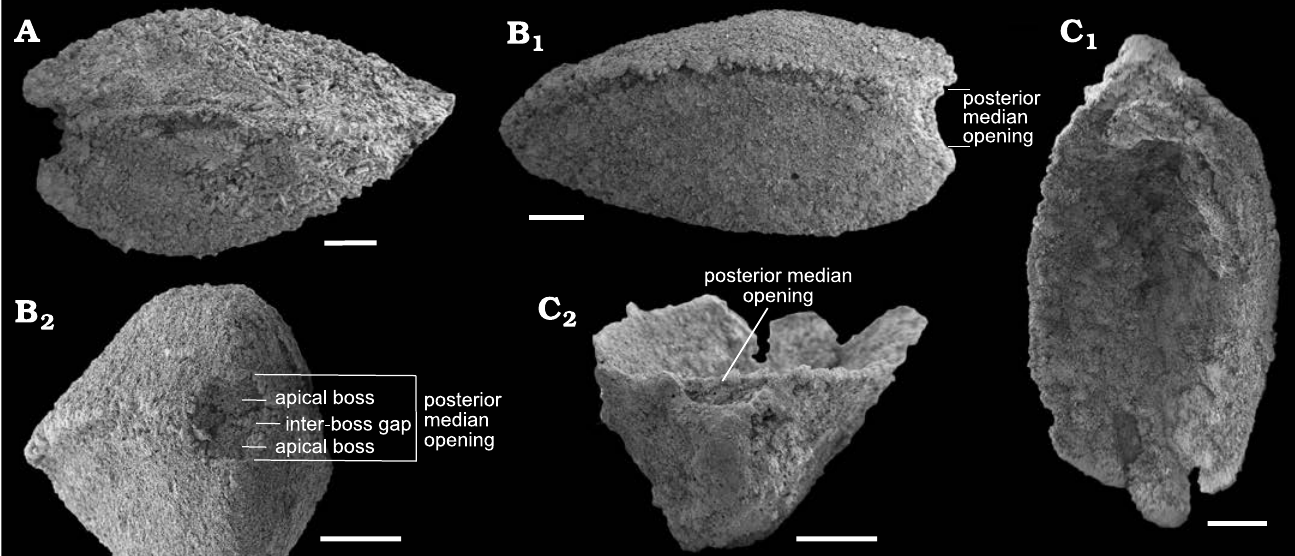
Fig. 7. SEM micrographs of stenothecoid pan-brachiopod Stenothecoides cf. elongata , middle Cambrian, Burgess Shale Formation, Kootenay National Park, Canada, Locality 3. A . ROMIP 66248, articulated shell in right lateral view. B . ROMIP 66249, articulated shell in left lateral (B 1 ) and posterior (B 2 ) views. C . ROMIP 66250, ventral valve in interior (C 1 ) and posterior (C 2 ) views. Scale bars 500